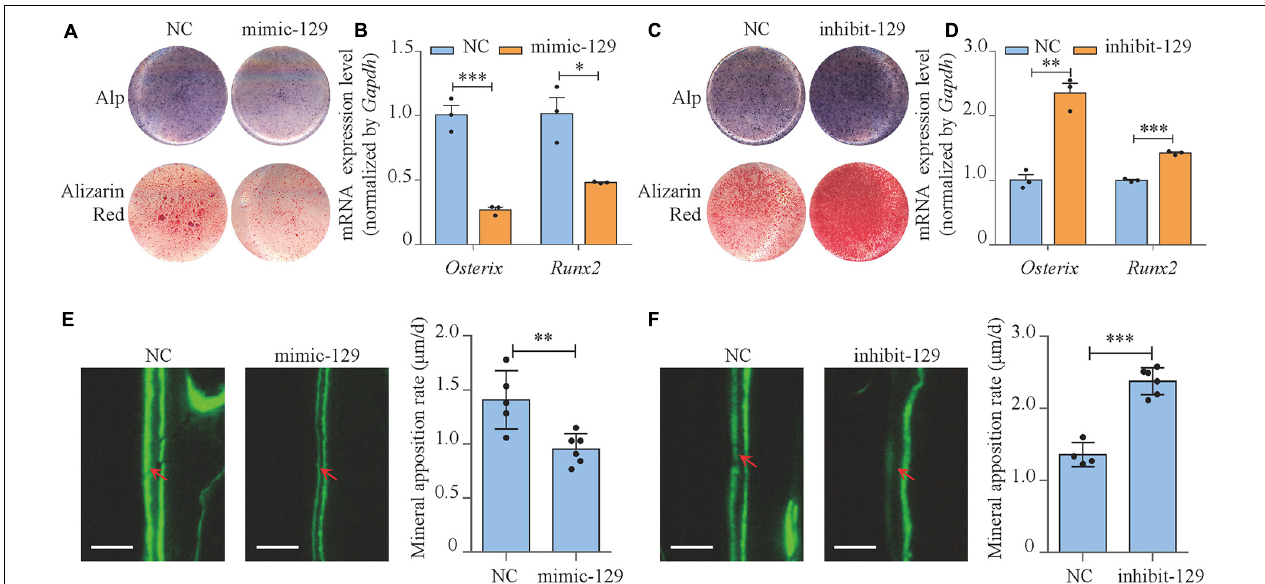
FIGURE 2 | miR-129-5p inhibited osteoblast differentiation and bone formation. (A) Alp and alizarin red staining of MC3T3-E1 cells treated with mimic-129-5p (compared to mimic-NC), as detected by Alp staining and alizarin red staining. Alp, results of Alp staining; alizarin red, results of alizarin red staining; NC, mimic-NC; mimic-129, mimic-129-5p. (B) Osterix and Runx2 expression levels of MC3T3-E1 cells treated with mimic-129-5p, as detected by reverse transcriptase-polymerase chain reaction (RT-PCR; mean ± SD, ∗ P < 0.05, ∗∗∗ P < 0.001). (C) Alp and alizarin red staining of MC3T3-E1 cells treated with inhibitor-129-5p (compared to inhibitor-NC), as detected by Alp staining and alizarin red staining. NC: inhibitor-NC. inhibit-129: inhibitor-129-5p. (D) Osterix and Runx2 expression levels of MC3T3-E1 cells treated with inhibitor-129-5p, as detected by RT-PCR (mean ± SD, ∗∗ P < 0.01, ∗∗∗ P < 0.001). (E) Calvarial bone mineral apposition rate of C57BL/6 mice treated with mimic-129-5p (mean ± SD, ∗∗ P < 0.01). Scale bar: 10 µ m. (F) Calvarial bone mineral apposition rate of C57BL/6 mice treated with inhibitor-129-5p (mean ± SD, ∗∗∗ P < 0.001). Scale bar: 10 µ m.